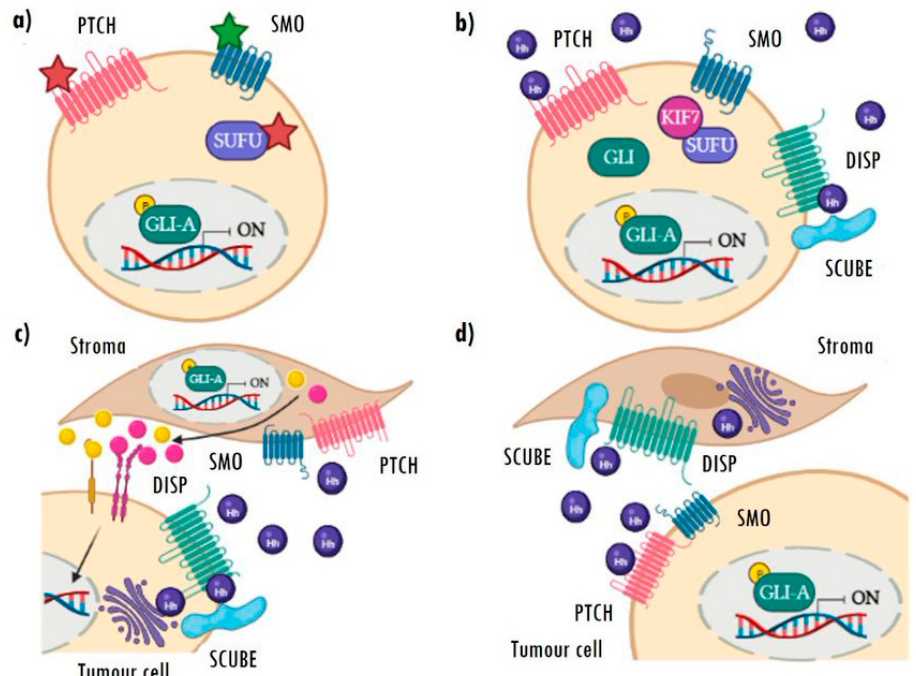
Figure 3. Aberrant mechanisms of Hh pathway activation. ( a ) Type I: ligand-independent constitutive activation caused by inactivating (red star) or activating (green star) mutations in different components of the pathway. ( b ) Type II: autoactivation of cells by high autocrine secretion of ligands. ( c ) Type III: paracrine Hh activation of stromal cells dependent on tumour cell ligand secretion, which, in turn, re-stimulates the tumour via pro-oncogenic Hh target secreted factors. ( d ) Type IIIb: reverse paracrine activation, in which stromal cells secrete Hh ligands and activate signalling in the tumour cells. Image created with BioRender.